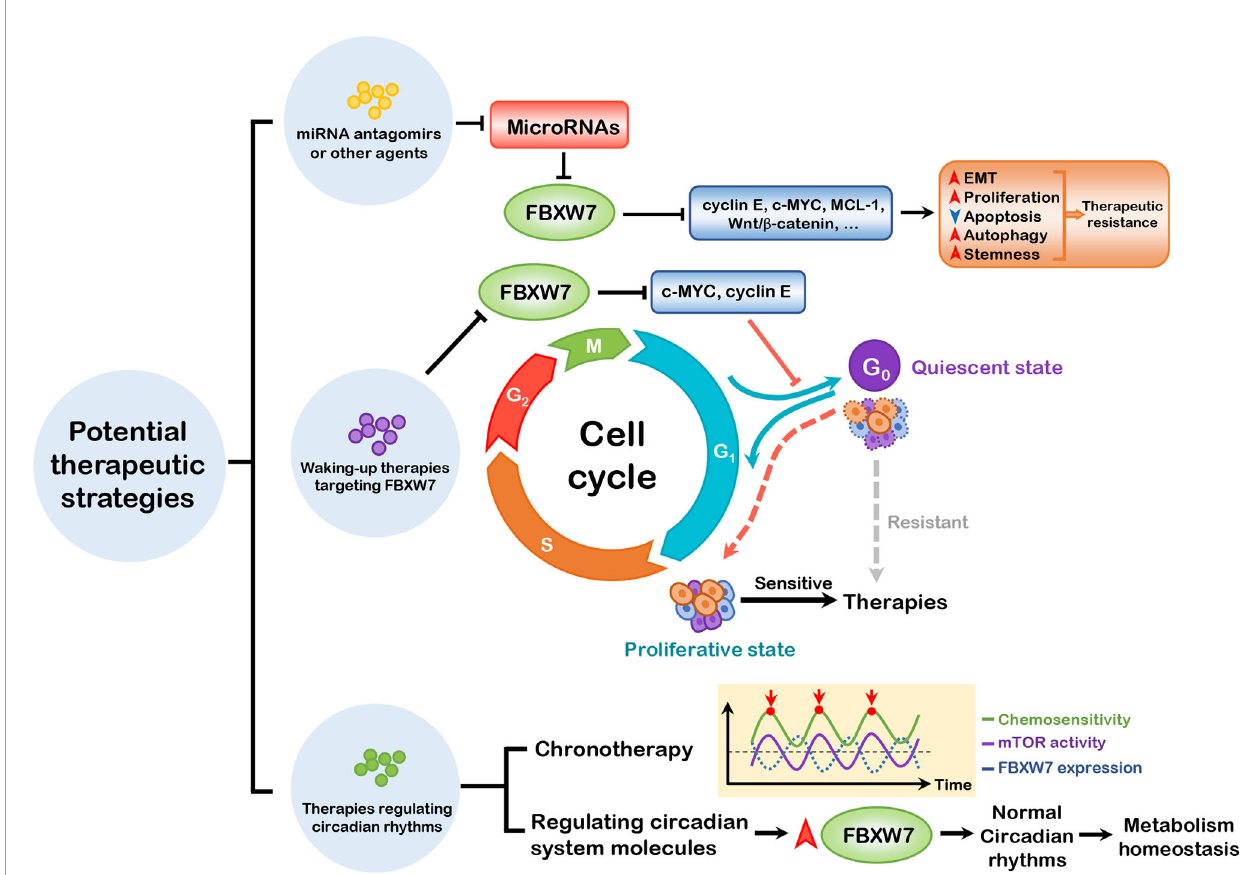
FIGURE 4 | Three potential therapeutic strategies. miRNA antagomirs or other agents can be administered to block the suppression of FBXW7 expression by miRNAs, thus inhibiting the substrates of FBXW7, which promote EMT, proliferation, autophagy, and stemness and dampen apoptosis to induce therapeutic resistance. Waking- up therapies can be applied to prevent exit of cells from cell cycle regulated by FBXW7, thus waking up cancer stem cells from quiescent to proliferative state. Based on the role of FBXW7 in regulating circadian rhythms, it is ponderable to introduce chronotherapy and elevating FBXW7 expression to attain better therapeutic ef fi cacy. EMT, epithelial – mesenchymal transition; MCL-1, myeloid cell